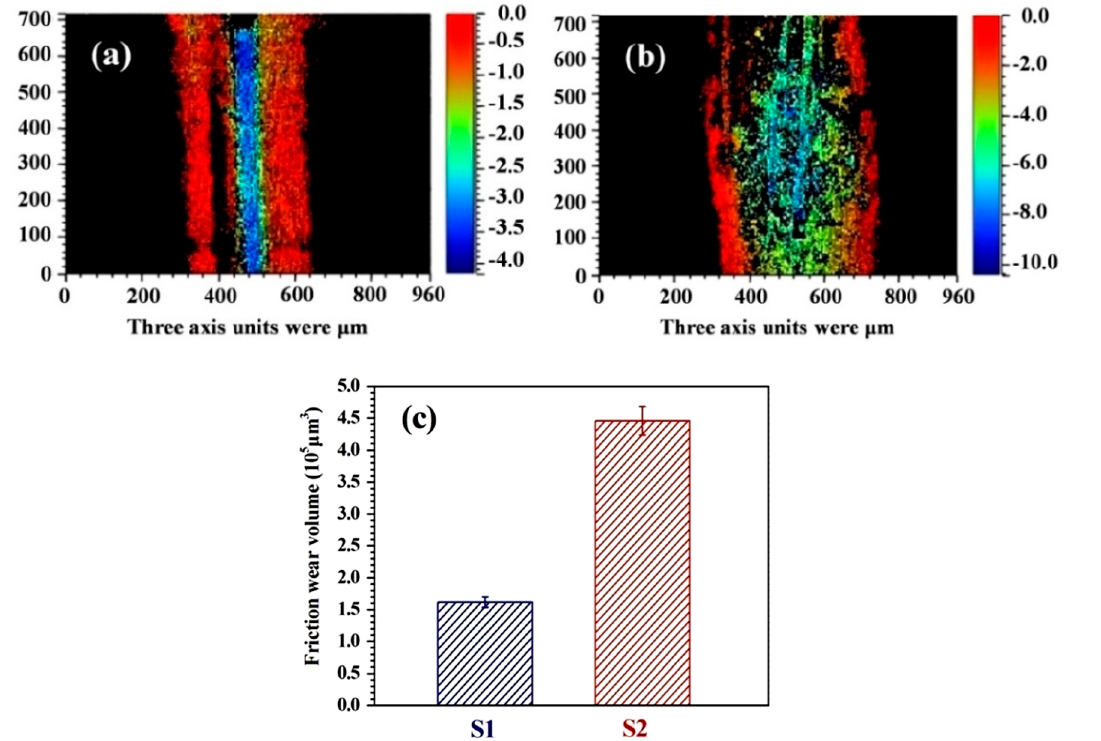
Figure 4. ( a ) Three-dimensional morphologies of wear scars in S1 and ( b ) S2 cladding layers ( c ) wear volume of the cladding layers.